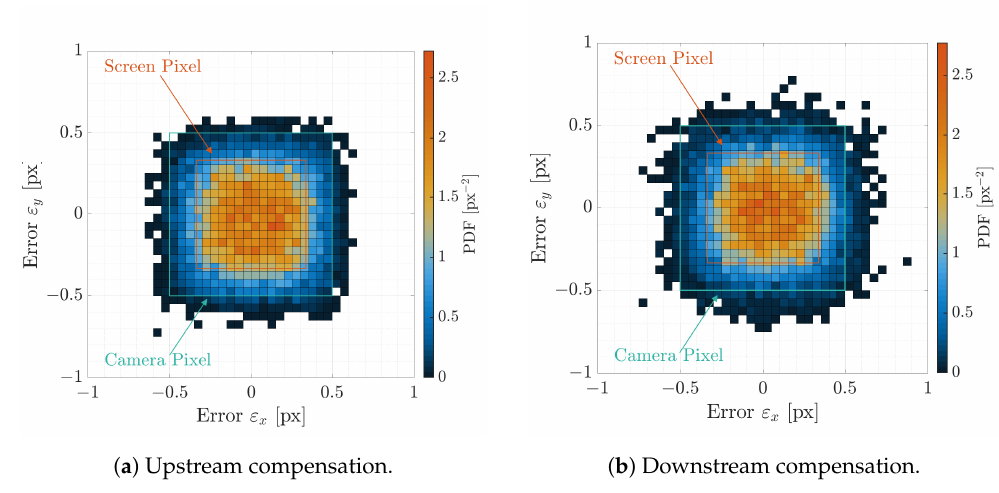
during the two proposed compensations. The IFoV and the screen iFoV θ s . IFoV IFoV